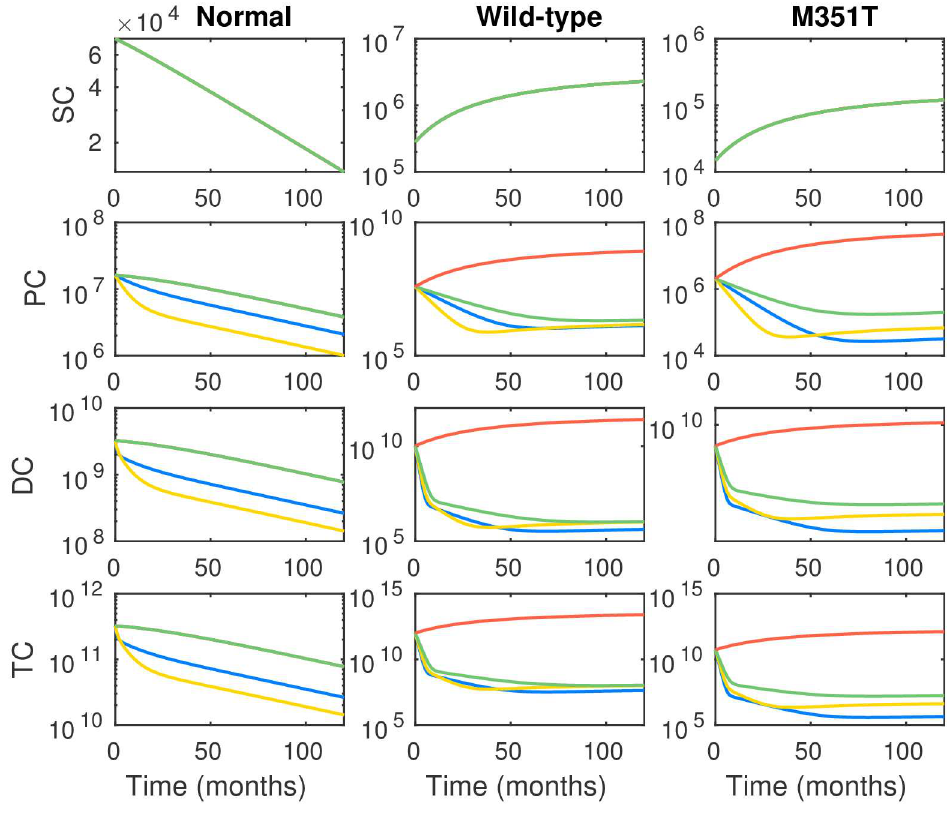
Fig 3. Long term dynamics of healthy, WT leukemic and M351T mutant leukemic cell populations under treatment with standard regimen monotherapy nilotinib (blue), dasatinib (yellow), imatinib (green) and no drug (orange). The unit of vertical axis is number of cells. The dynamics of healthy normal PC, DC and TC with imatinib monotherapy(green) and no drug (orange) coincide,since the birth and death rates of normal PC, DC and TC under imatinib monotherapy happento be the same as the corresponding birth and death rates of normal PC, DC and TC with no drug. Initial conditionsare provided in Table 1 and parameter choices are provided in Section A of S1